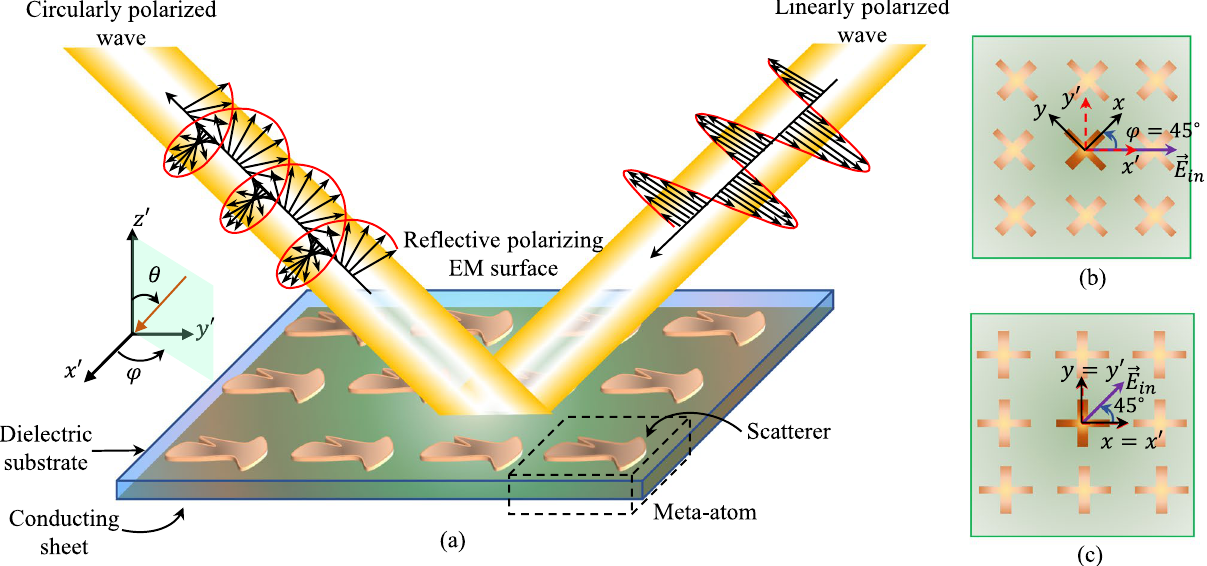
Figure 1. ( a ) A reflective polarizer shown with the relation between the coordinate systems of the polarizering scatterer, ( x , y ), and the uniform array ( x the angle from the x